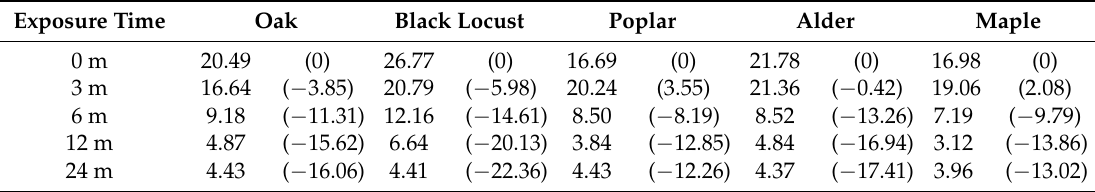
Table 6. Exposure time-dependence of b * value (chromaticity differences ∆ b * are in brackets). The data represent mean values. Exposure Time Oak Poplar Alder Maple